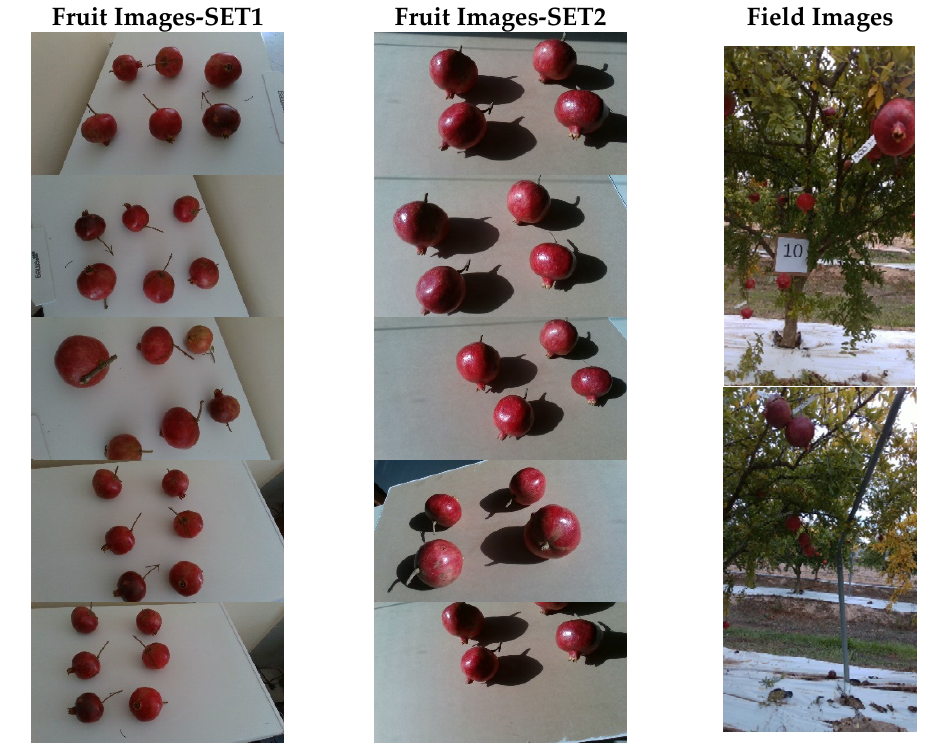
Figure 2. Sample images from the different data sets: controlled environment acquisitions under uniform ( left ) and non-uniform ( center ) exposure; field images acquired by the robotic platform ( right ).